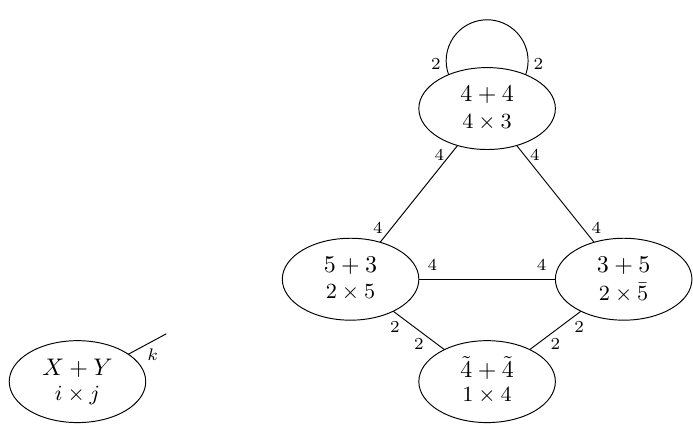
Figure 16 . Spurious pole structure of the N = 7 6-point NMHV amplitude. The legend on the lower left represents an X + Y diagram topology containing i terms in the permutation sum, each with j spurious poles. The edge represents k pairs of spurious poles which cancel against spurious poles appearing on the other end of the